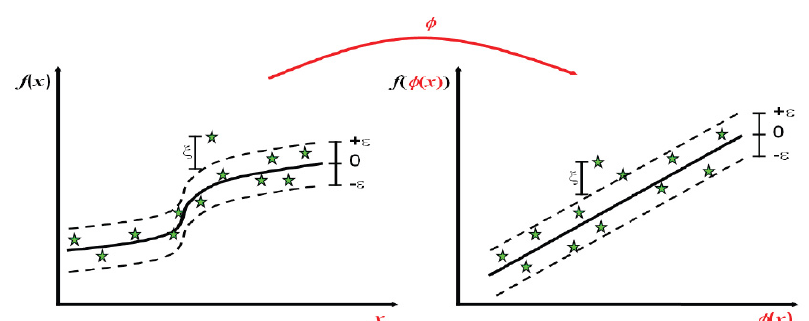
Figure 3. Support vector regression (SVR). Stars mean representative data samples, a solid line is a central fitting, and dashed lines denote the upper and lower limit.